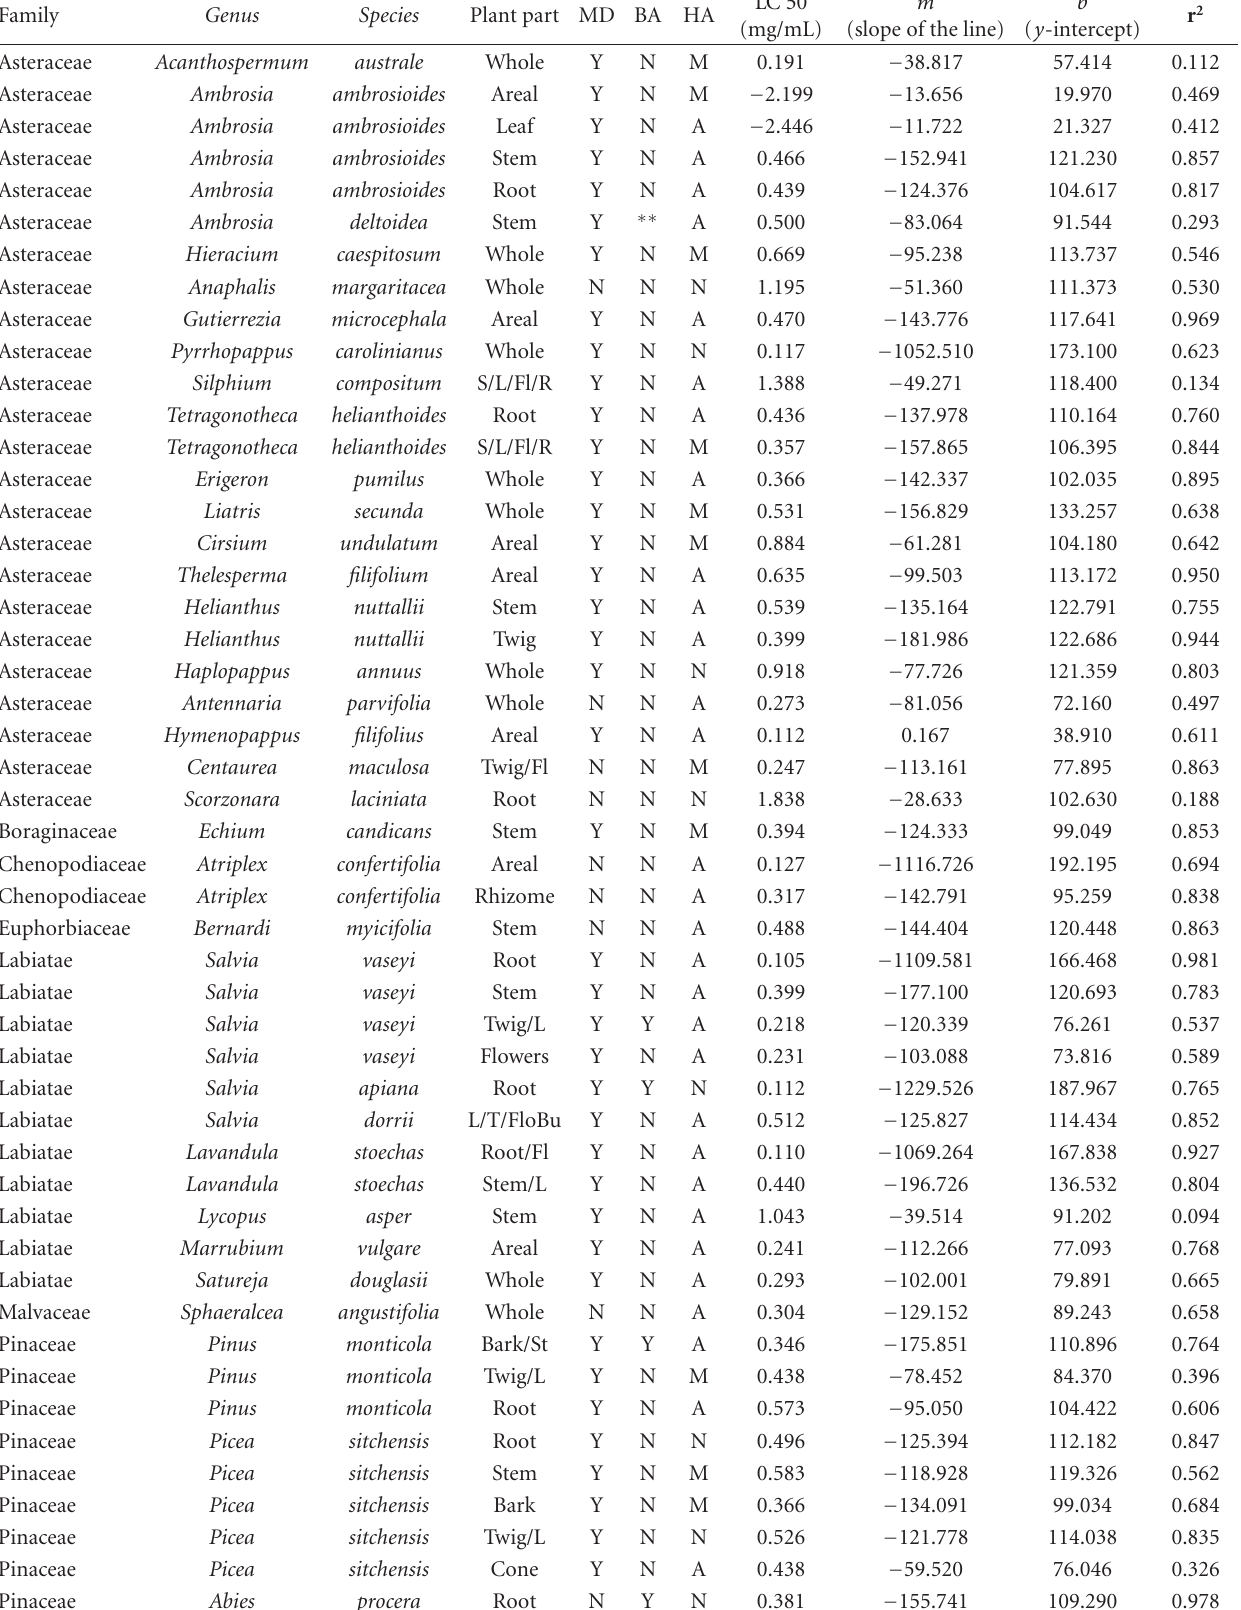
Table 1: Cytotoxicity of selected plant extracts to bacterial cells and HeLa cancer